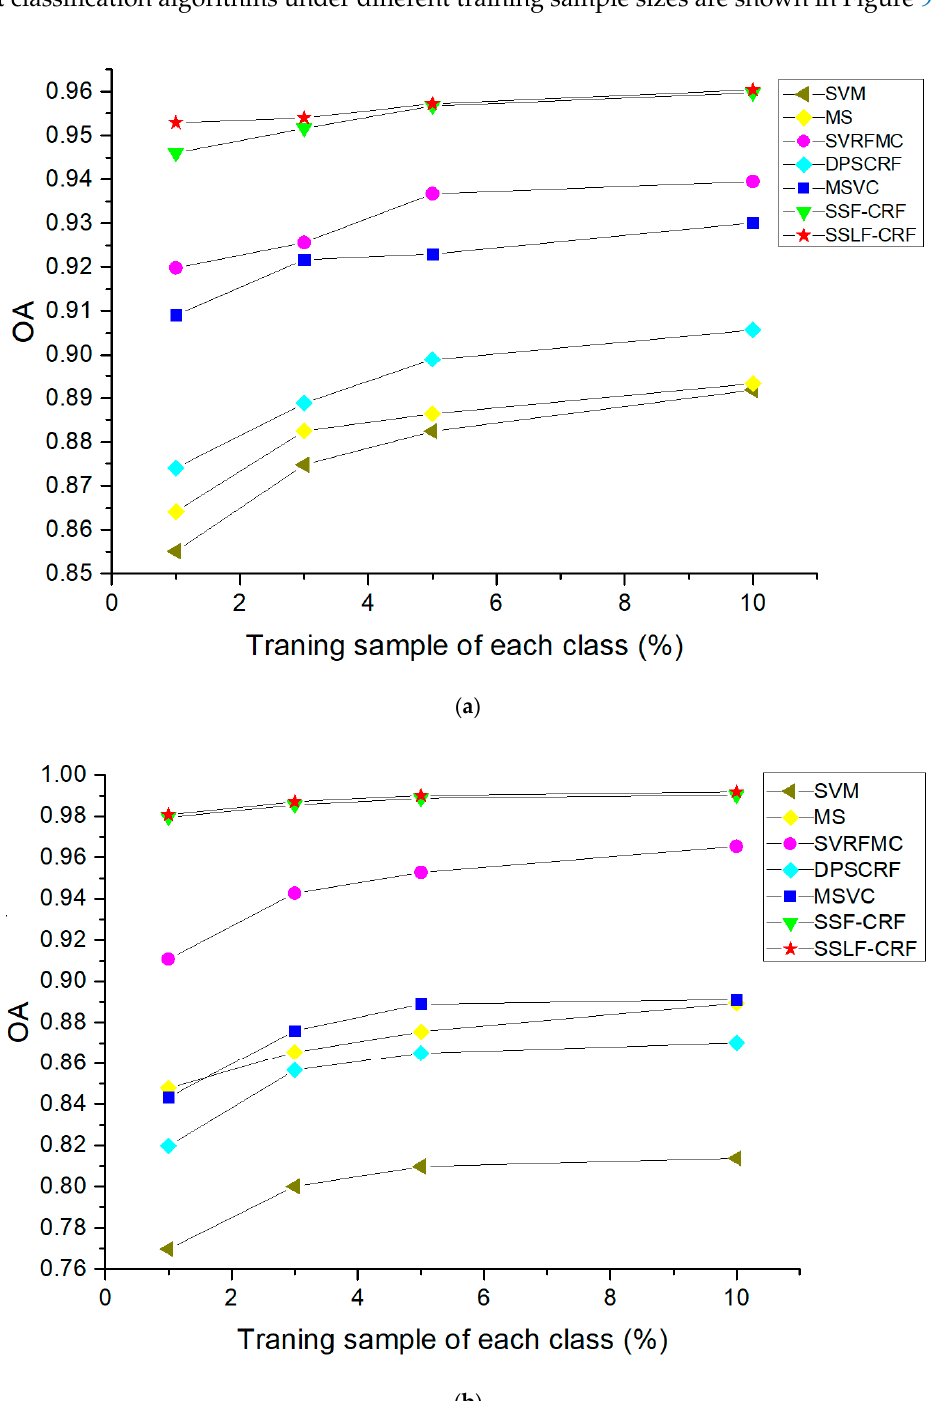
Figure 9. Sensitivity analysis for the training sample size: ( a ) Hanchuan dataset; ( b ) Honghu dataset.